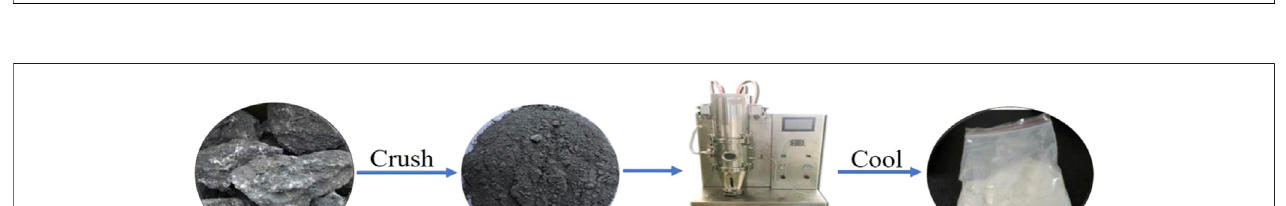
FIGURE 5 | SCA treatment via roasting.